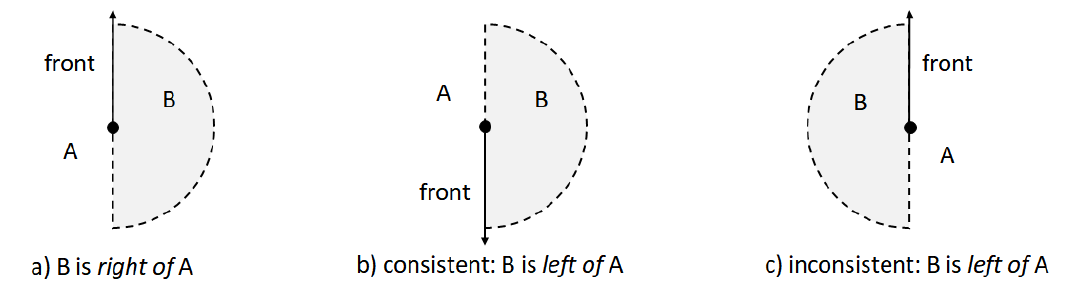
Figure 11. Determining consistency of directional relationships between a locatum B and a relatum A by search spaces. ( a ) an existing relationship and its search space; ( b ) another relationship that is consistent with the existing one, determined by search space; ( c ) another relationship that is inconsistent with the previous two.